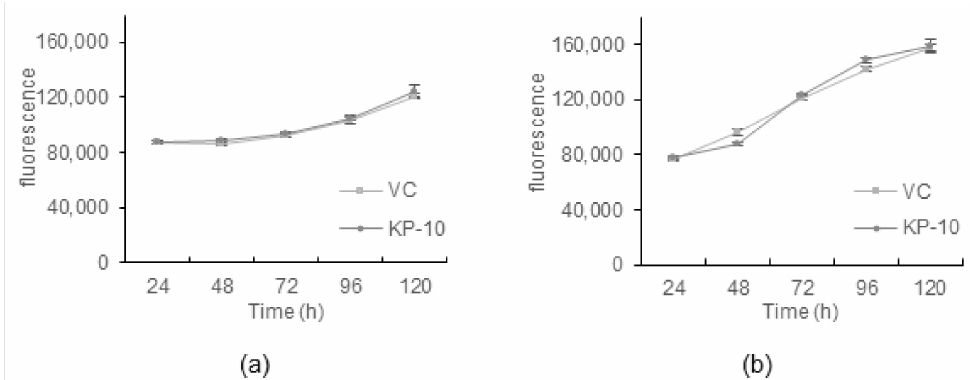
Figure 7. KP-10 has no effect on the proliferation of BT-20 or MDA-MB-231 cells. Proliferation of ( a ) BT-20 and ( b ) MDA-MB-231 cells was measured by resazurin conversion assay after 24, 48, 72, 96, and 120 h treatment in the presence of 100 nM KP-10 or the vehicle control (VC) under serum-free culture conditions. Data are presented as the mean ± SEM from three independent